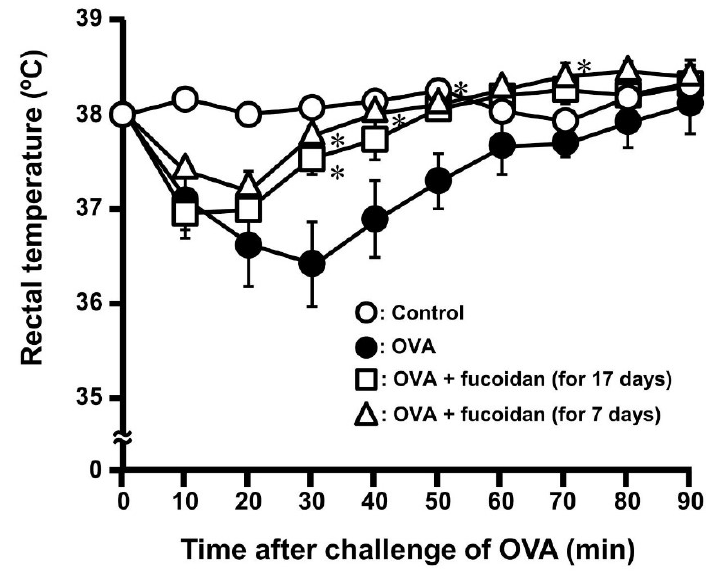
Figure 3. Suppressive effect of F-fucoidan on rectal temperature induced by OVA injection. Mice were immunized by injection of OVA and orally administrated F-fucoidan (60 μg/mouse/day) as described in the Materials and Methods. Rectal temperature was measured as described in Figure. 1. * p < 0.05 significantly different from the values of the group that was not administrated F-fucoidan and injected OVA (OVA control). Values represent means ± SEM of 4-5 mice in each group.